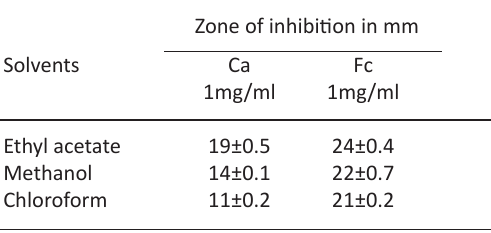
Table 4. Bioactivity of crude extracts of A.flavus against fungal